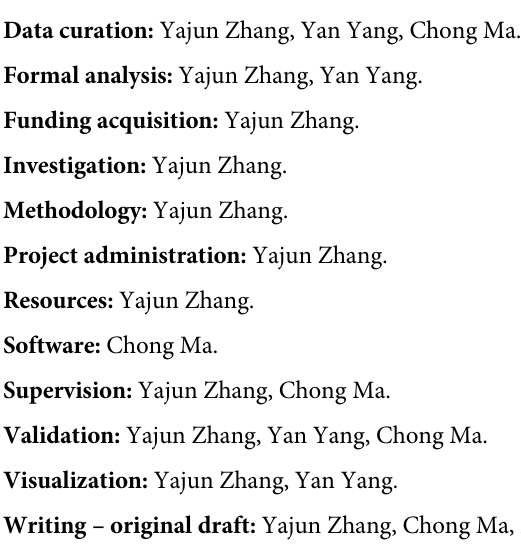
S1 Table. The precision, recall and f1score of the